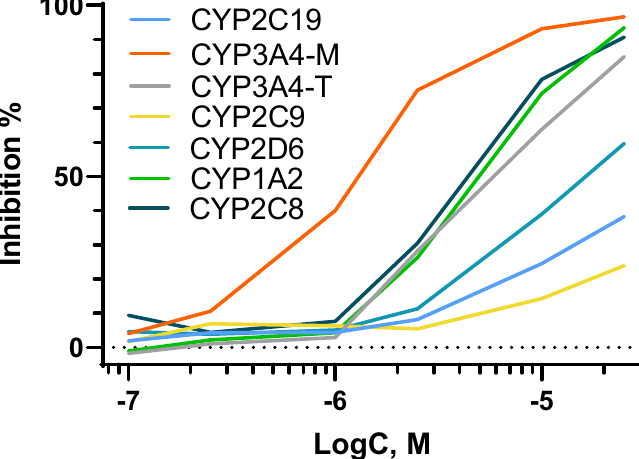
Figure 5. Inhibition of P450 cytochromes by PSMA-Abi . Table 3. Inhibition of series of P450 cytochromes (1A2, 3A4-M, 3A4-T, 2C8, 2C9, 2C19, and 2D6) by PSMA-Abi and a series of reference